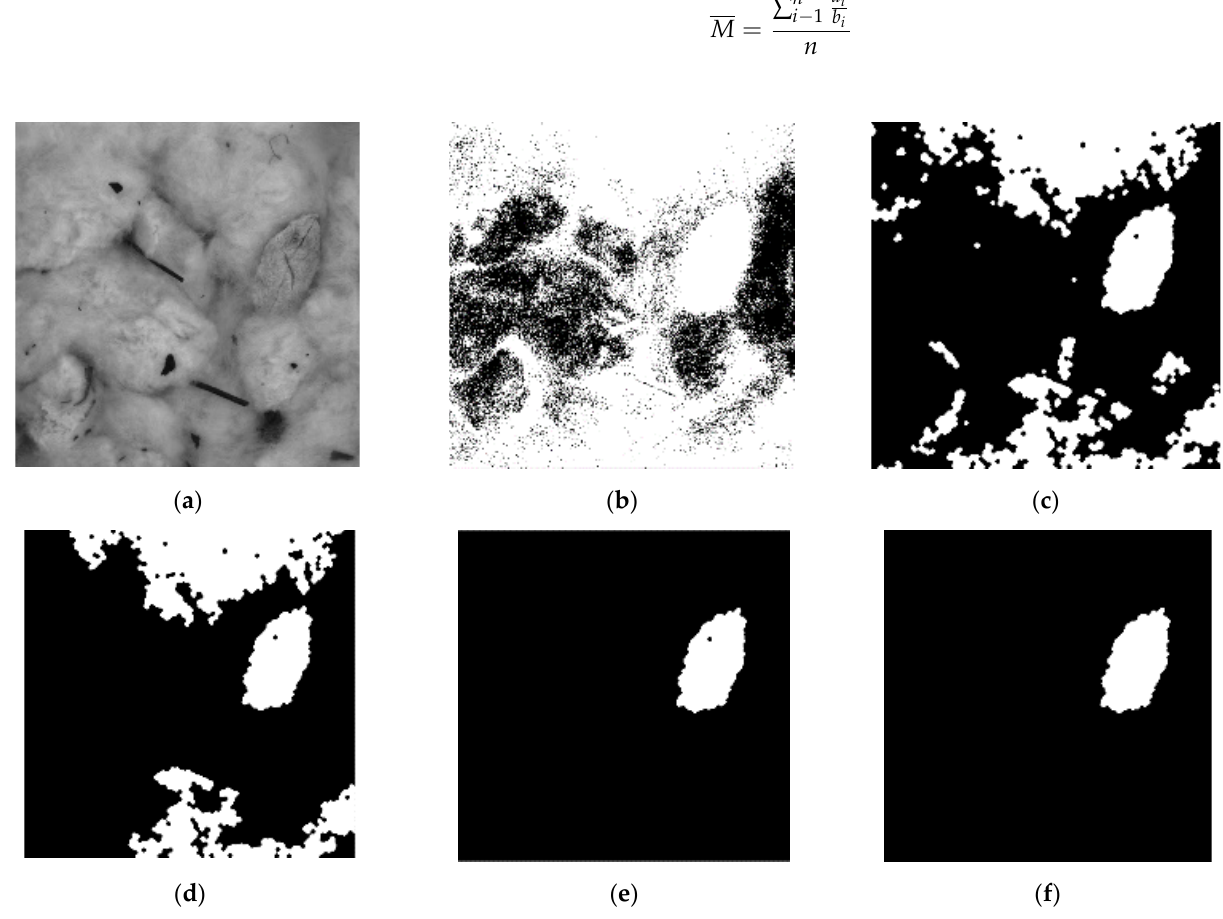
Figure 4. Segmentation of a light-color impurity image under the b channel. ( a ) The original image; ( b ) extracted b channel; ( c ) zone filling; ( d ) removal of small areas; ( e ) removal of the cotton background; ( f ) hole filling.